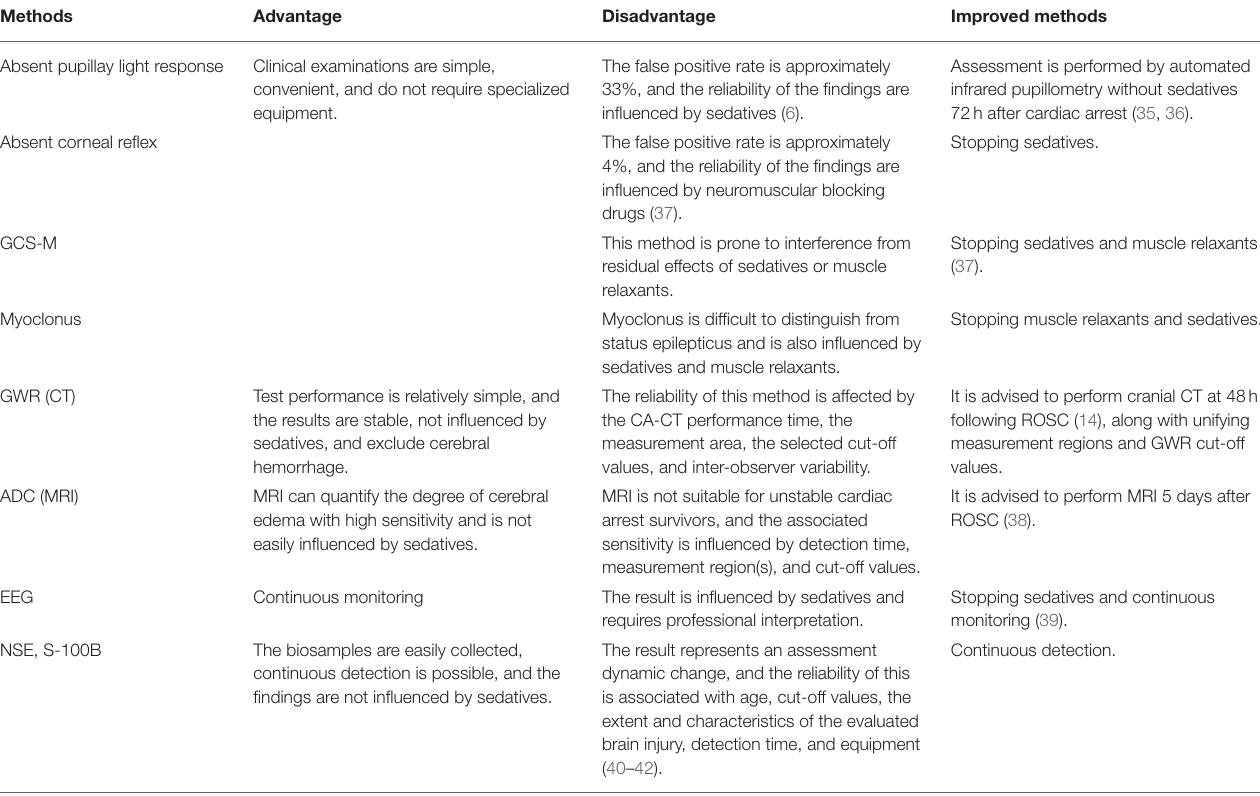
TABLE 4 | The comparative advantages and disadvantages of common examinations and tests predicting neurologic outcomes.